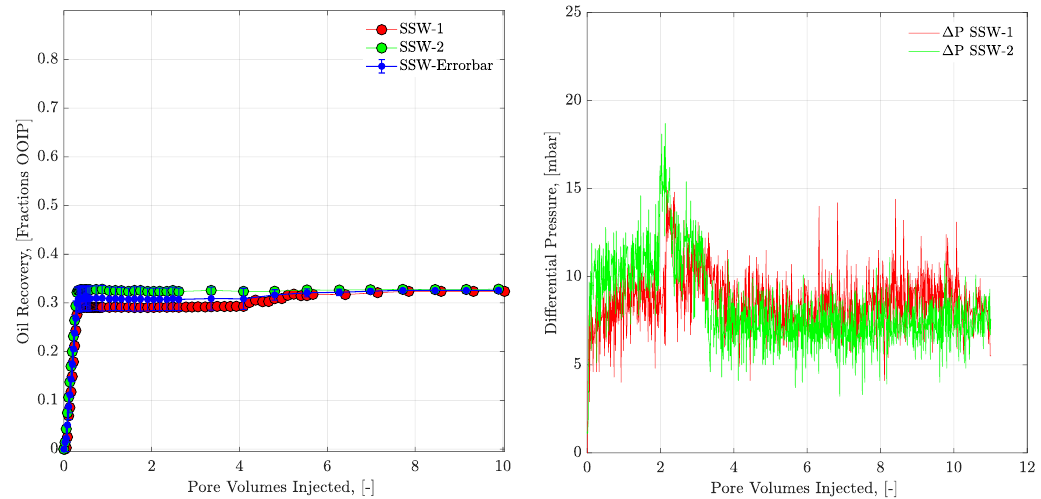
Figure 8. Oil recovery and pressure drop versus PV injected for artificial structure oil-wet micromodel. SSW injection is performed as the secondary mode for both flooding experiments.